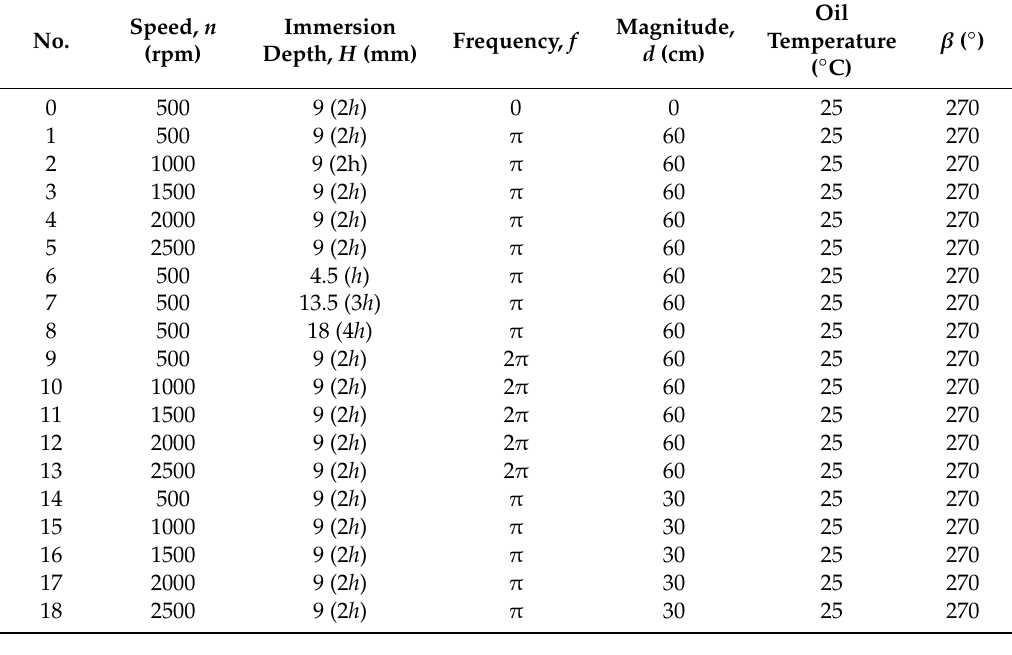
Table 3. Parameter combinations for simulations.